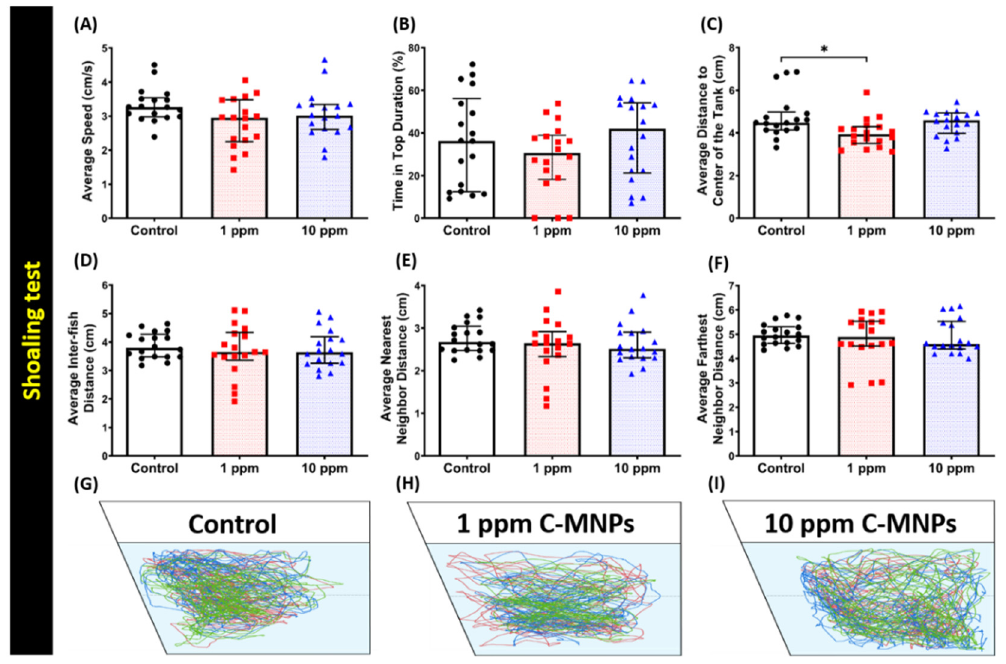
Figure 5. Behavior endpoint comparisons among the control group, 1 ppm, and 10 ppm C-MNPs-exposed zebrafish groups after two weeks of exposure. ( A ) Average speed, ( B ) time in the top duration, ( C ) average distance to the center of the tank, ( D ) average inter-fish distance, ( E ) average nearest neighbor distance, and ( F ) average farthest neighbor distance were analyzed. ( G – I